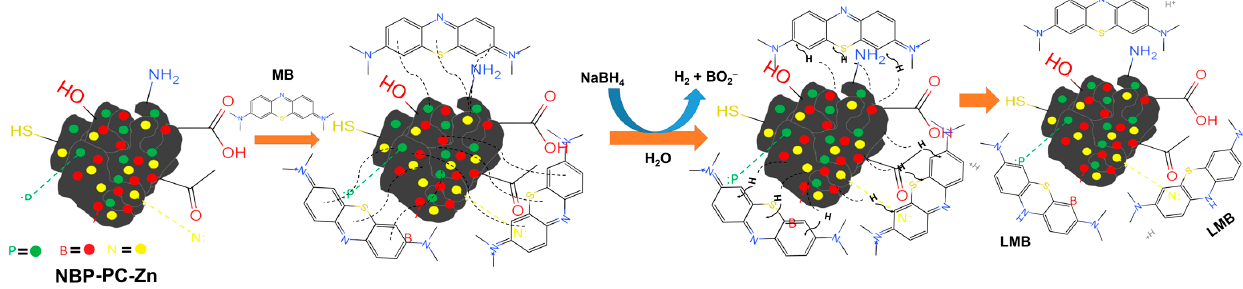
Figure 5. Possible catalytic mechanism of MB reduction over NBP-PC-Zn using NaBH 4